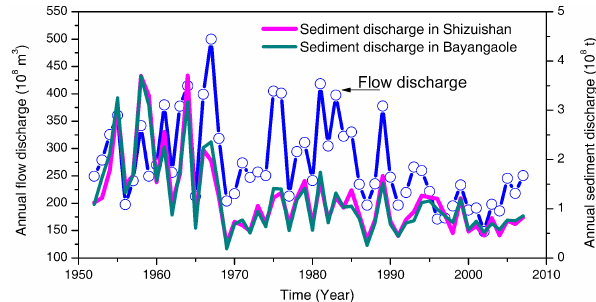
Figure 2. Changes in annual flow and sediment discharges moni- tored in the Shizuishan gauge and the Bayangaole gauge (data come from the YRCC) from 1955 to 2007 in the Yellow